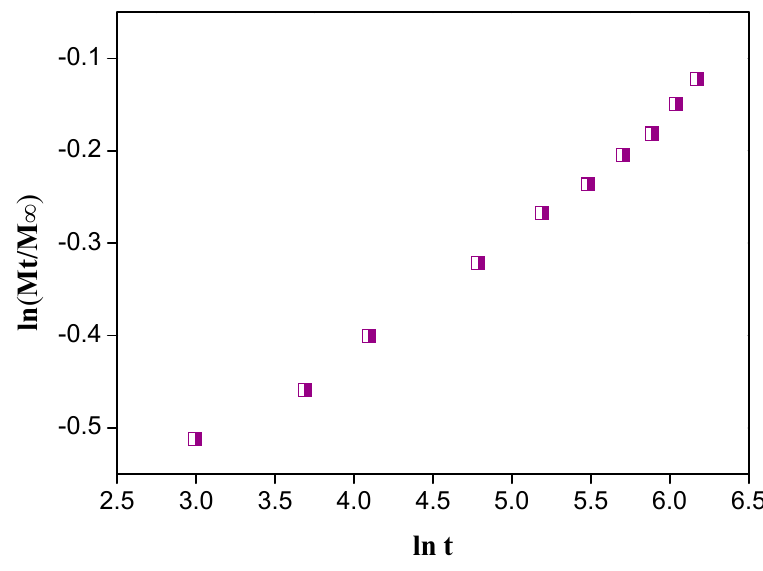
Figure 7. ln t versus ln(Mt/M ∞ ) plot for Fick’s rule.